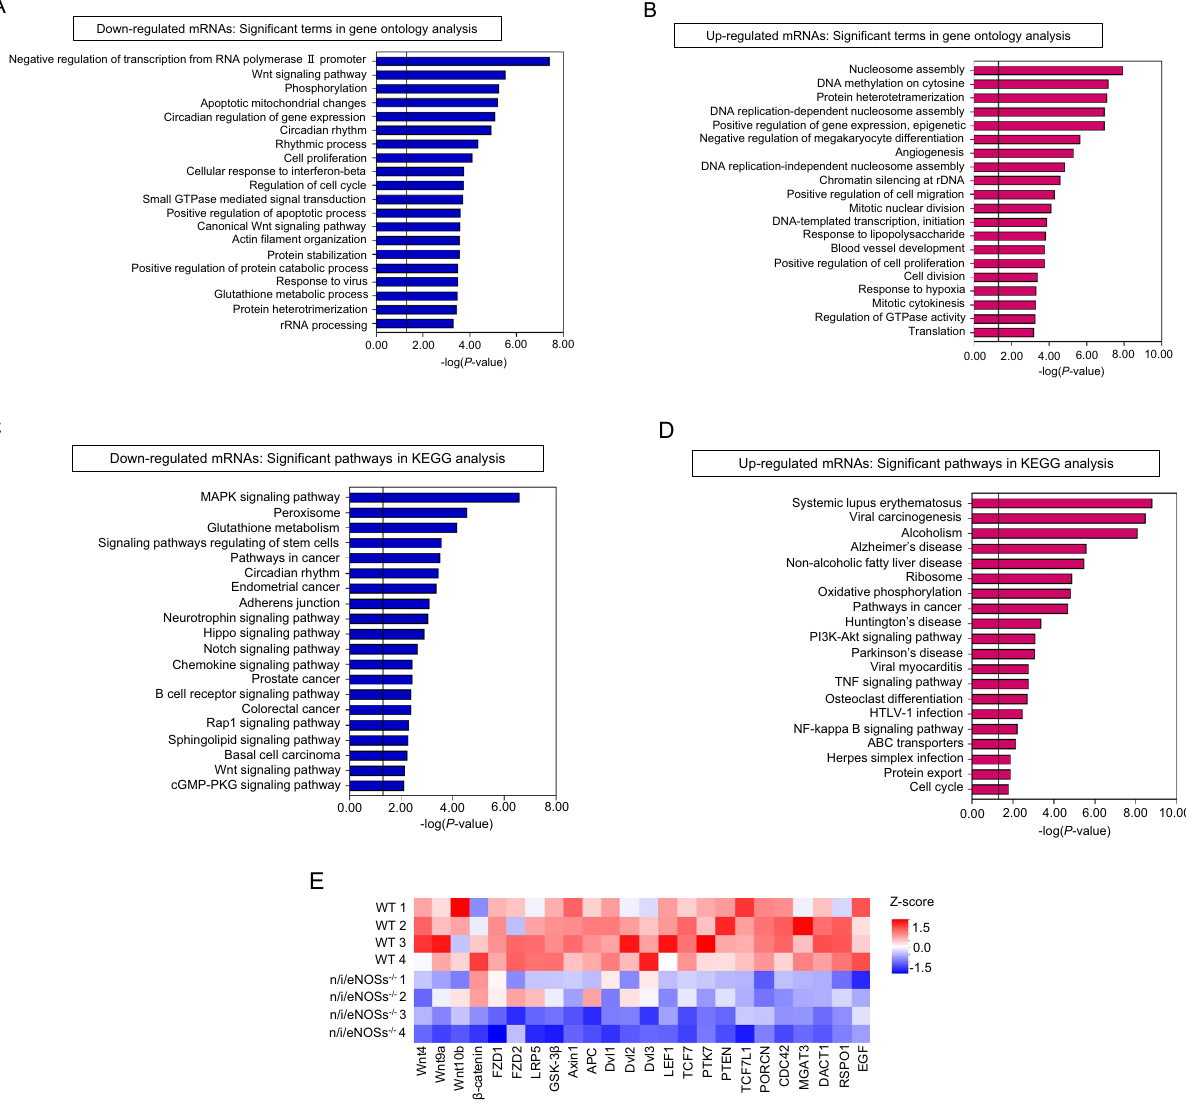
Figure 4. Gene ontology term enrichment analysis and KEGG pathway analysis of differentially expressed genes between the lungs of WT and triple n/i/eNOSs −/− mice. CAGE sequencing identified 4717 mRNAs which were differentially expressed between the lungs of the WT and n/i/eNOSs −/− mice with statistically significant differences ( P < 0.05) and more than 1.2-fold change (n = 4 each); 2108 and 2609 mRNAs were significantly up- and down-regulated, respectively, in the lungs of the triple n/i/eNOSs −/− mice. Database for Annotation, Visualization, and Integrated Discovery (DAVID) was used. Statistically significant biological process terms in the down-regulated (A) and up-regulated mRNAs (B) detected by the gene ontology term enrichment analysis. Statistically significant pathways in the down-regulated (C) and up-regulated mRNAs (D) detected by the KEGG pathway analysis. (E) Heat maps of significantly down-regulated genes in the lungs of triple n/i/eNOSs −/− mice as compared with the WT mice. The genes were categorized as Wnt/β-catenin signaling pathway in the gene ontology term enrichment analysis with DAVID. Statistical analysis was performed by Danaform Inc. (Kanagawa, Japan) as follows. The data of mRNA expression levels (gene counts) were corrected by size factors in order to normalize them by the normalization method of trimmed mean of M values (TMM). The corrected data were analyzed by the likelihood ratio test on a negative binomial distribution using edgeR as previously reported 22